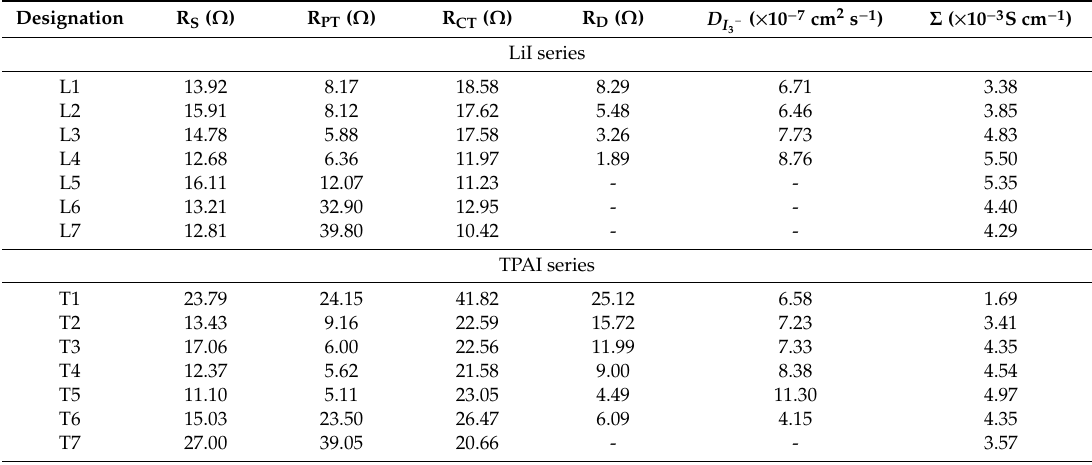
Table 4. Equivalent circuit parameters of phthaloyl starch and the HEC based